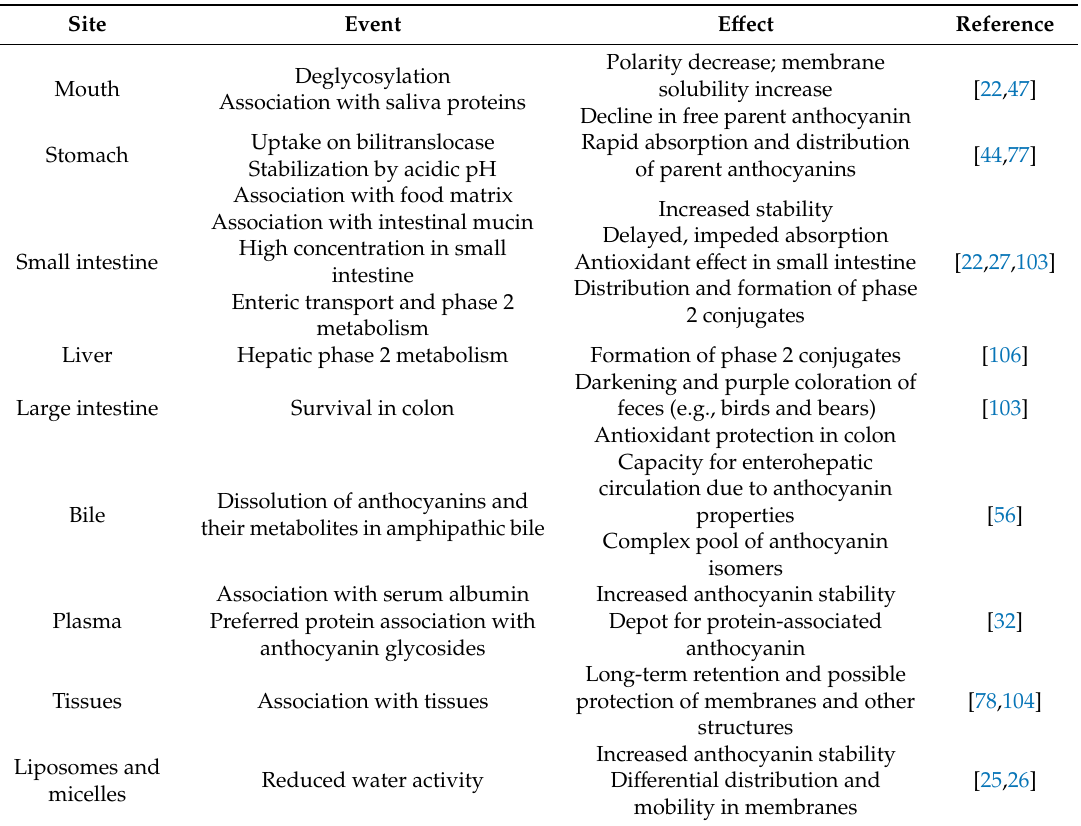
Table 1. Sites of occurrence of anthocyanins and their C 6 -C 3 -C 6 products in vivo, and the events and e ff ects associated with